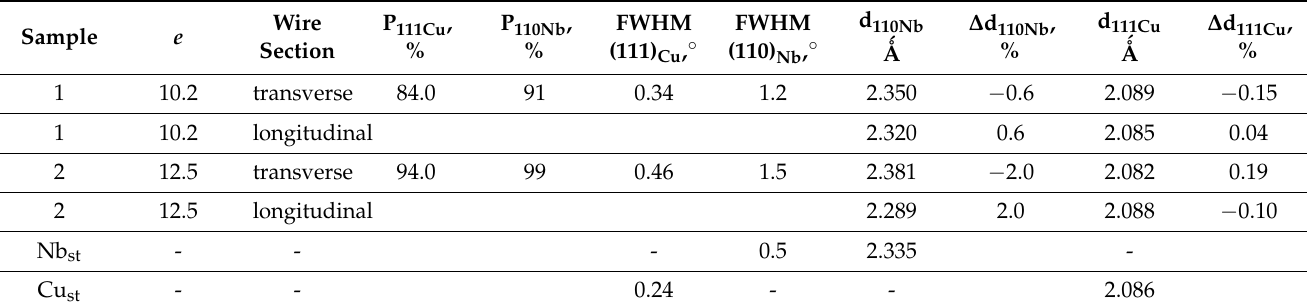
Table 1. Characteristics of samples based on the X-ray data.